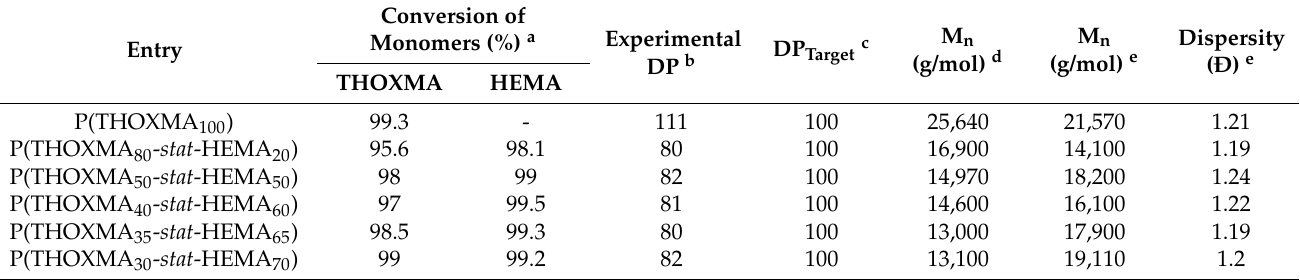
Table 1. Characterisation data of homopolymers and statistical copolymers prepared by RAFT.